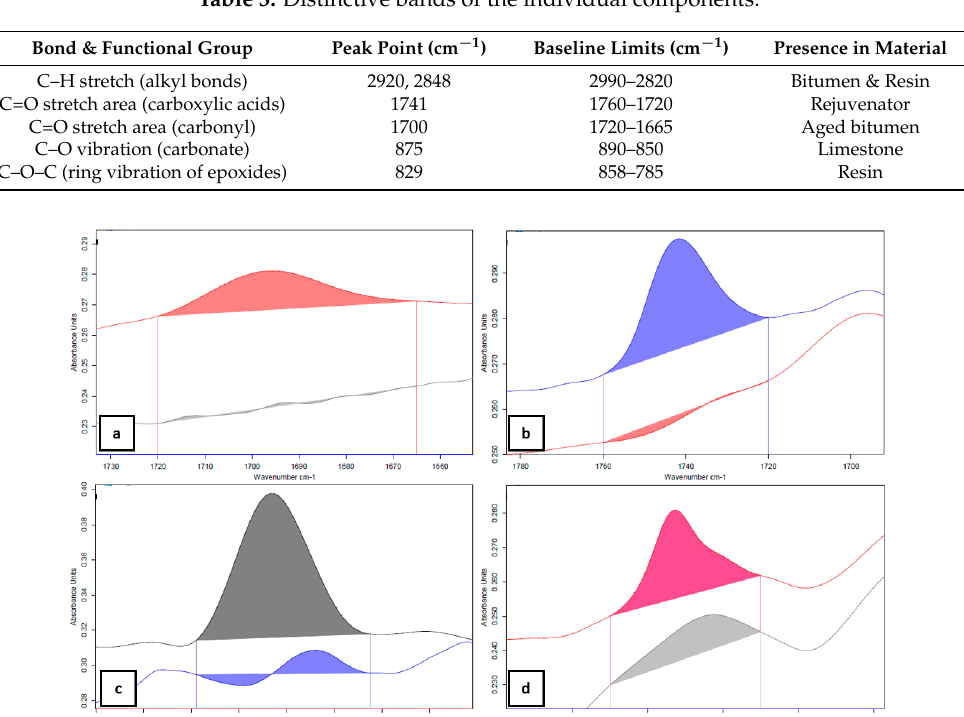
Figure 7. Carbonyl of RA bitumen (red) and neat bitumen (light grey) ( a ); carboxylic acids of rejuvenated bitumen (blue) and non-rejuvenated bitumen (red) ( b ); epoxides of resin (dark grey) and of bitumen (blue) ( c ); carbonate of bitumen with limestone filler (magenta) and bitumen without filler (light grey) ( d ).